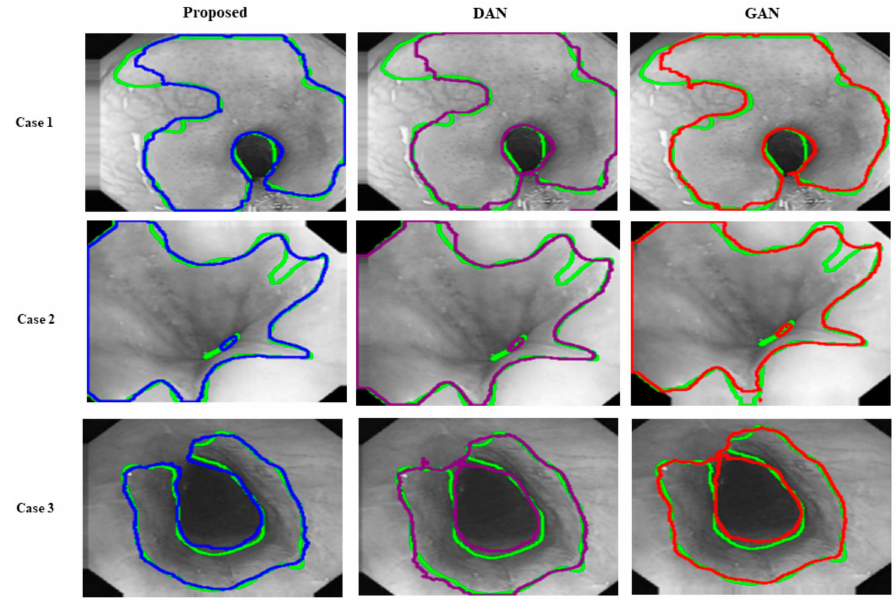
Figure 5. Visual samples of the segmentation performance of semi-supervised learning ( right ), ( middle ), and our method ( left ) on the test dataset. The green, yellow, purple, and red contours denote the GT, proposed, GAN, and DAN segmentation